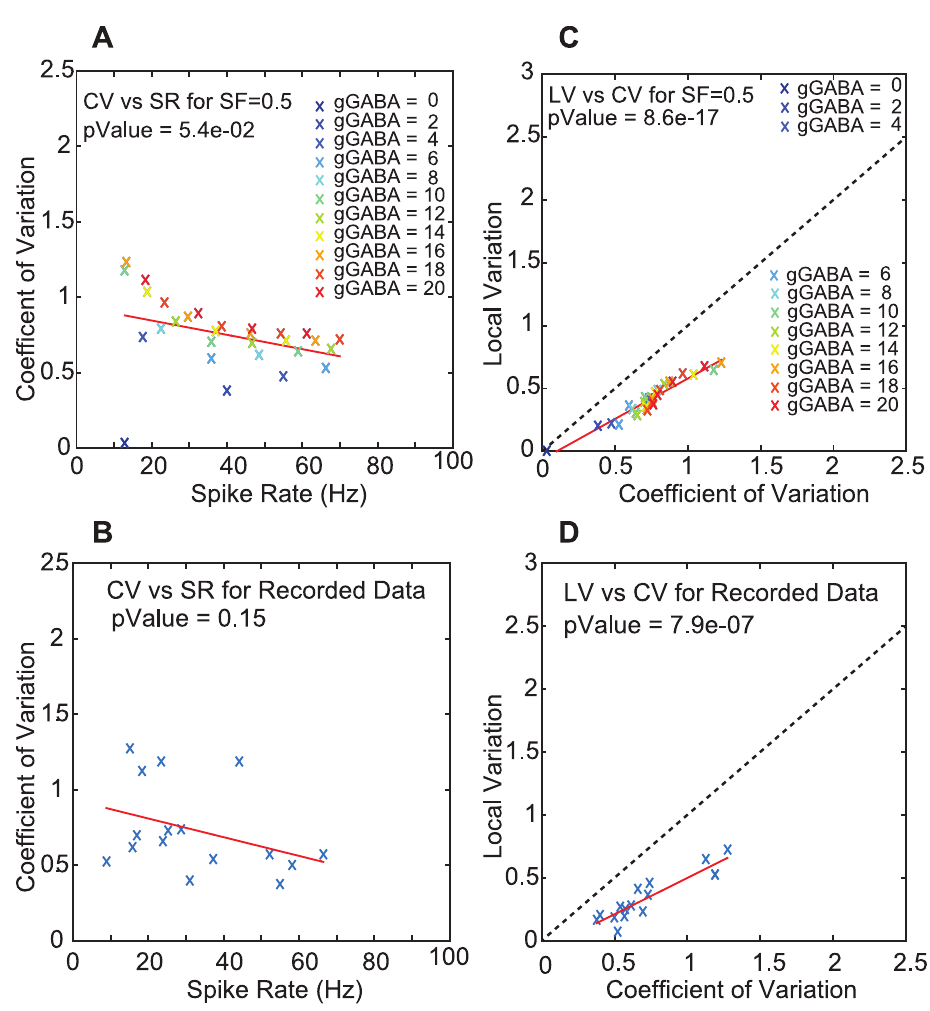
Fig 4. The CN model neuron spike statistics using different G in and G ex combinations fit the distribution of recorded spike train statistics. A. Model CV significantly decreases with SR (p-value for linear regressionis given). Variabilityat any given SR is introducedby different values of G in / G ex such that highertotal conductances result in a higher CV. B. The recordedCN neuronsshow a similar CV vs SR relationship but the CV variability at any given SR is higher. Each cross presents the mean SR of one recordedneuron. C,D. Model and data show a strong linear correlationbetweenLV and CV. The recorded population is best matched by models employinginputs with a SF of 0.5 (subset of Fig